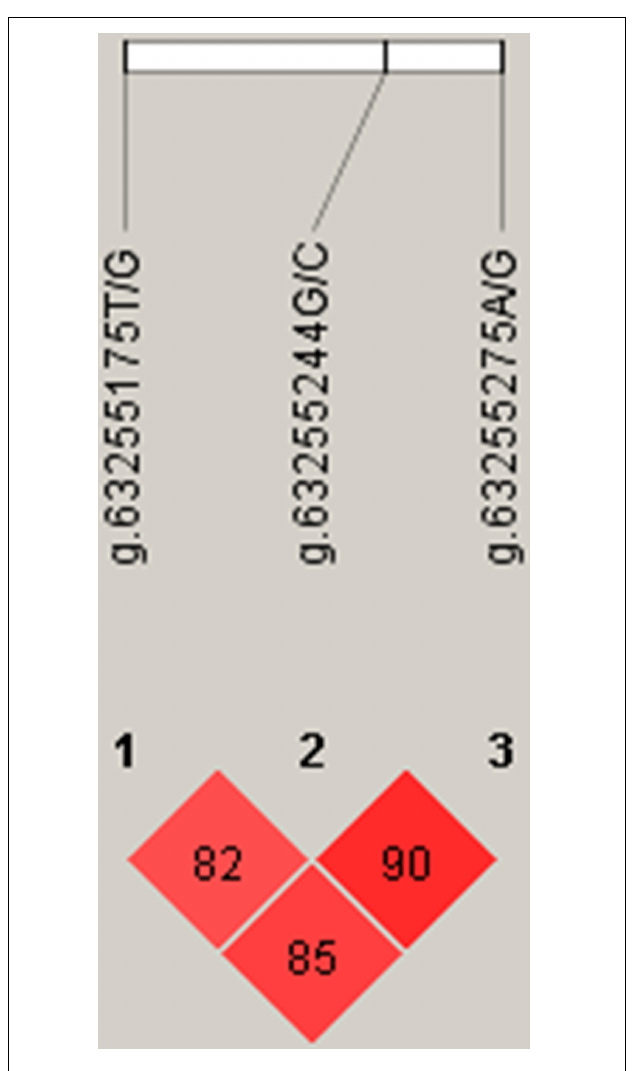
FIGURE 5 | Linkage disequilibrium (LD) analyses of SNPs near s26859.1.